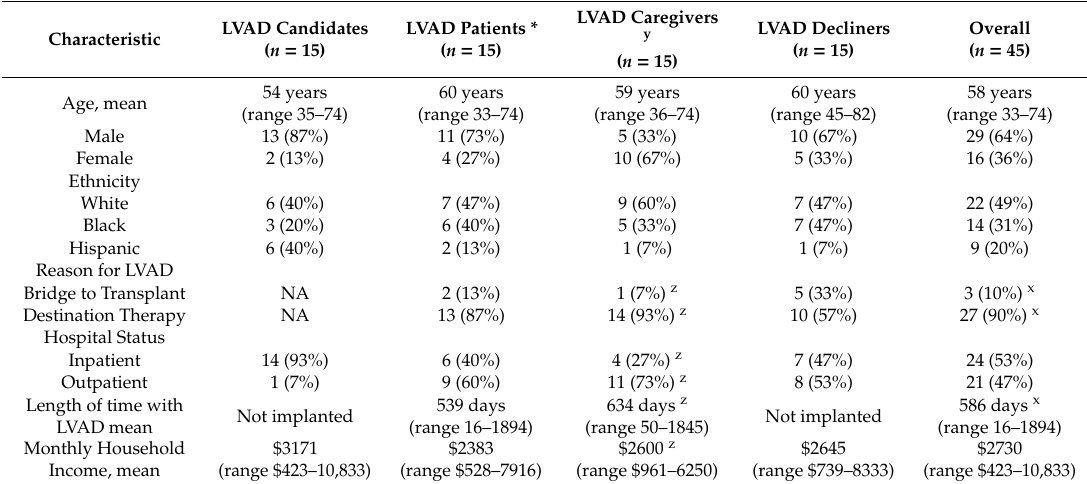
Table 1. Characteristics of sample: LVAD patients, candidates, and